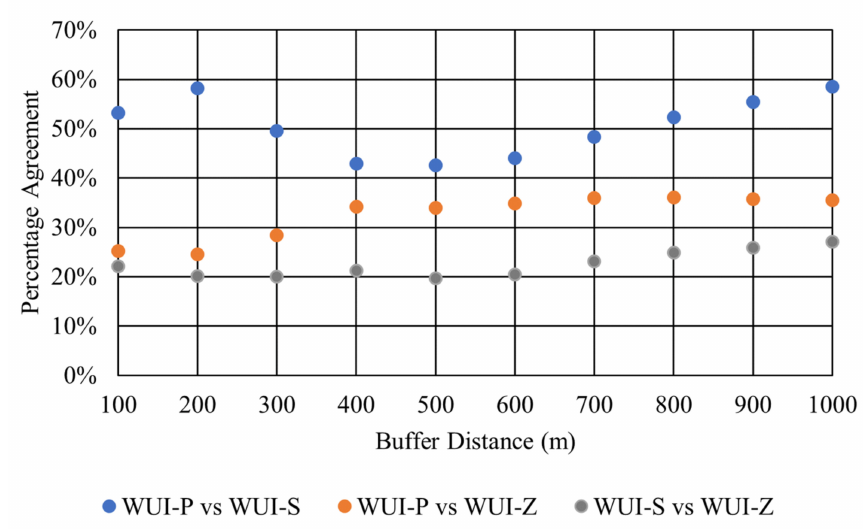
Figure 7. Percentage agreement between different types of WUI.